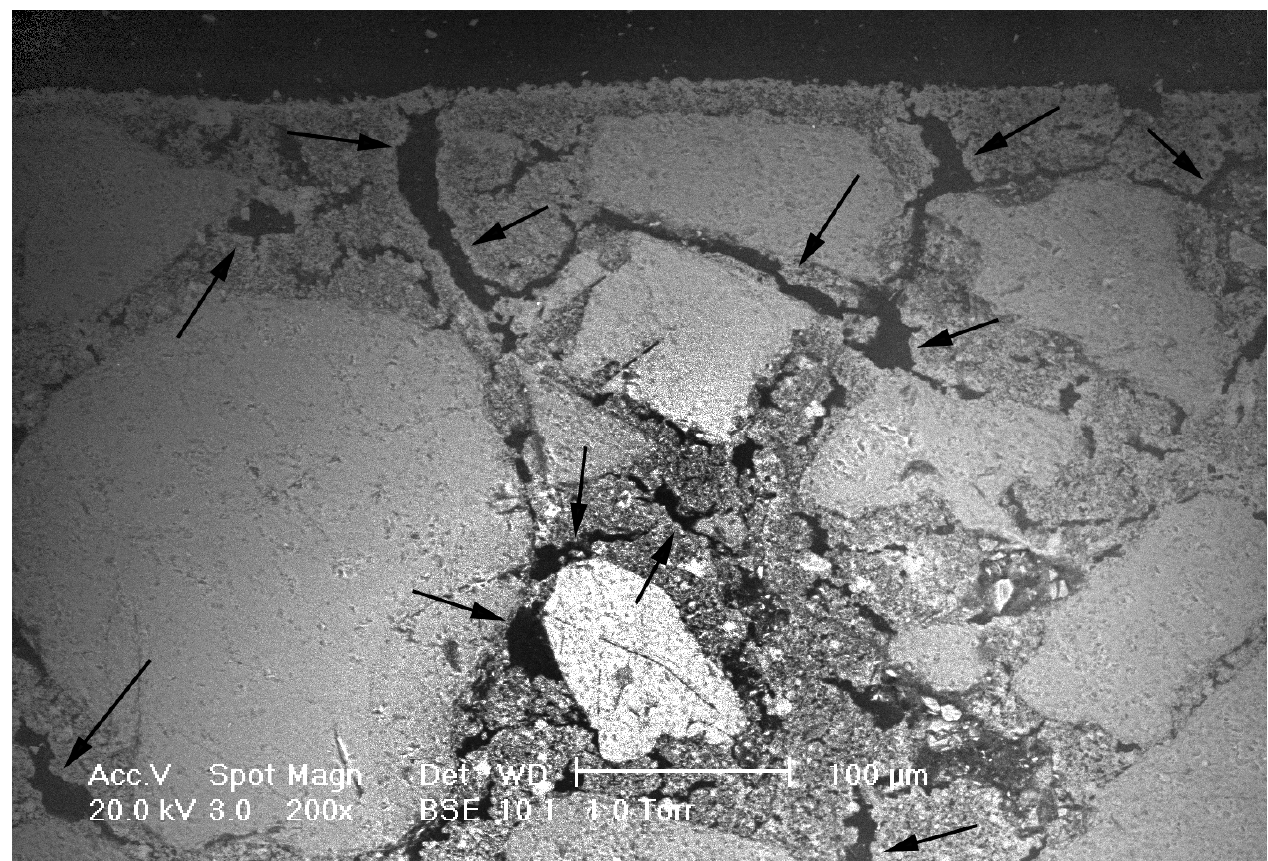
Figure 5. SEM image in back-scattered electron mode of the sample GQ, composed of a lime putty binder with quartz sand aggregate. Cracks are well visible in the matrix (arrows).